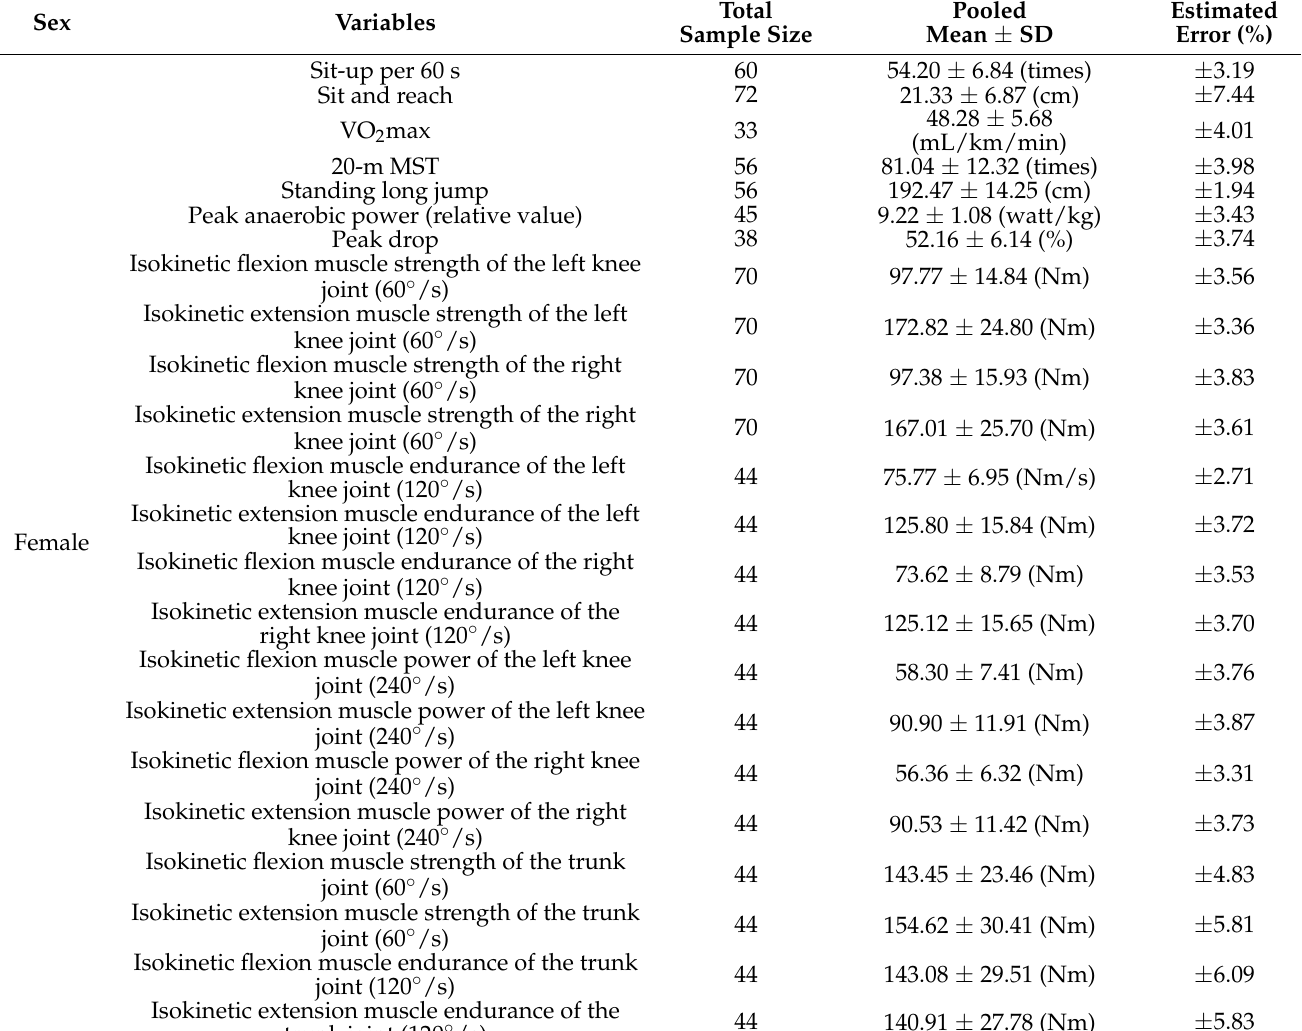
Table 5. Pooled and estimated statistics for the female Taekwondo athletes’ physical